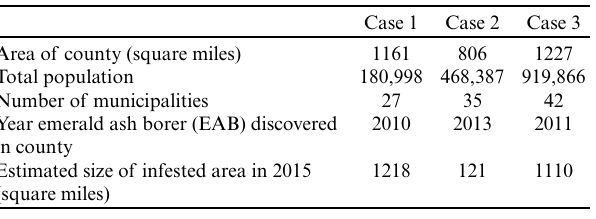
Table 1 . Background information on case study locations.